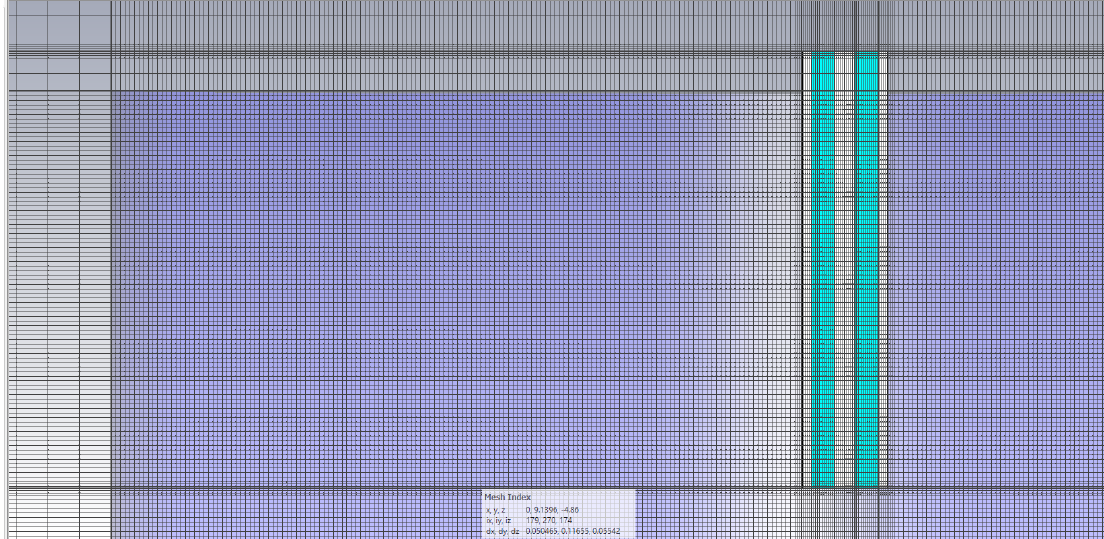
Figure 4. CST model mesh cross-section, truncated on the right and on the bottom to ensure the visibility of the important features of the mesh, showing the cross-section of the whole probe and the upper-left part of MUT (compare to Figure 2b) surrounded by the model box.